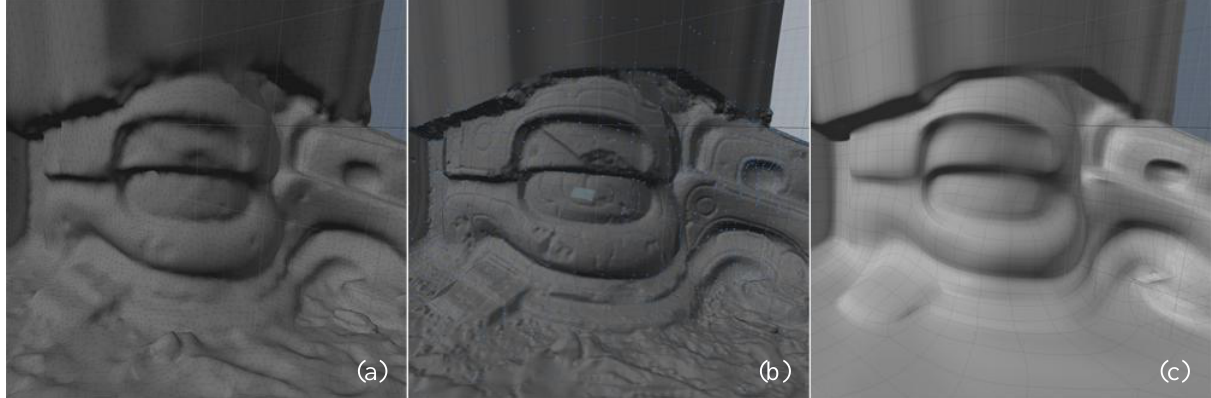
Figure 4. Different optimized mesh: (a) Triangular isotropic mesh. (b) Quad-dominant mesh. (c) Subdivision surface.